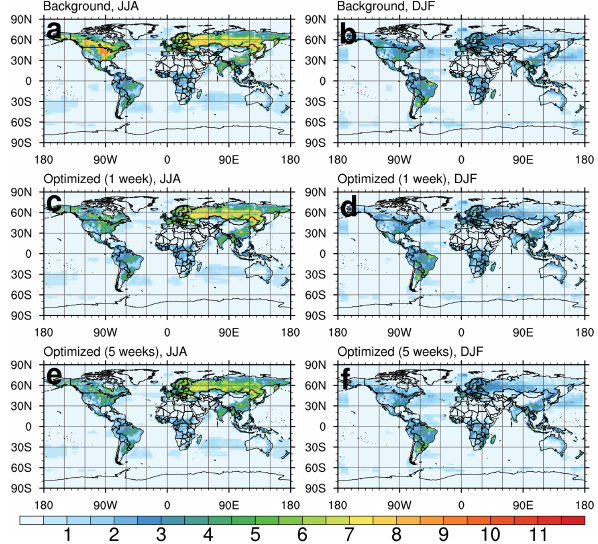
Figure 8. Average standard deviation of background biosphere and ocean fluxes in (a) JJA and (b) DJF; the posterior biosphere and ocean fluxes optimized by 1-week observations in (c) JJA and (d) DJF; and the posterior biosphere and ocean fluxes optimized by 5 weeks of observations in (e) JJA and (f) DJF. The units are in grams of carbon per square meter per week (gCm − 2 week − 1 ).